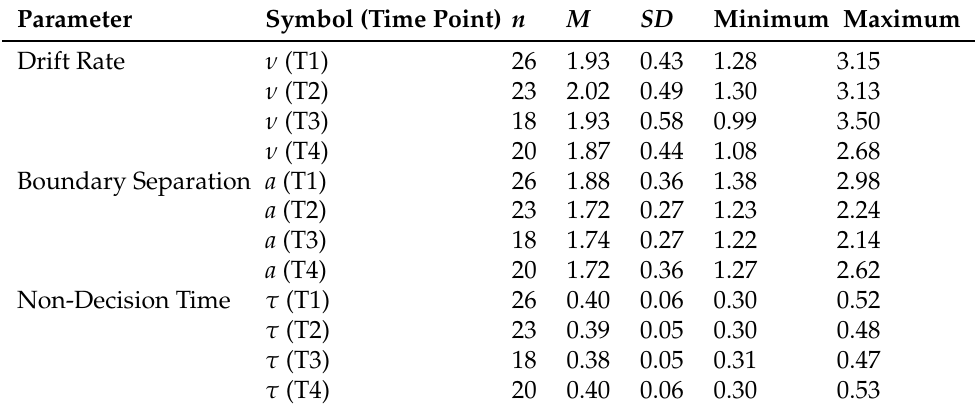
Table A4. Summary statistics of the individual diffusion model parameter estimates for each time point for Group